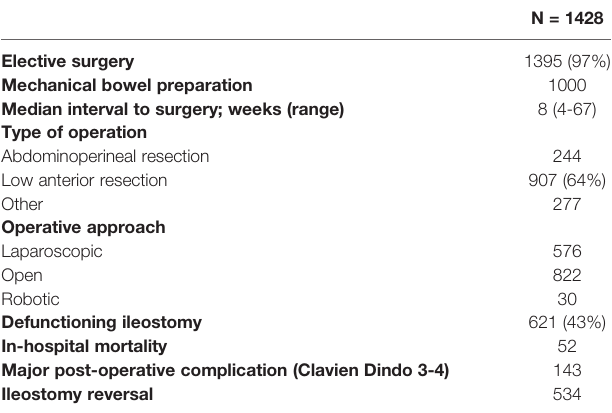
TABLE 2 | Operative details and post-operative